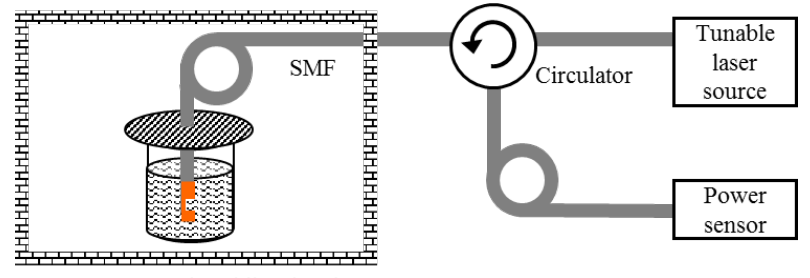
Figure 8. Experimental setup.